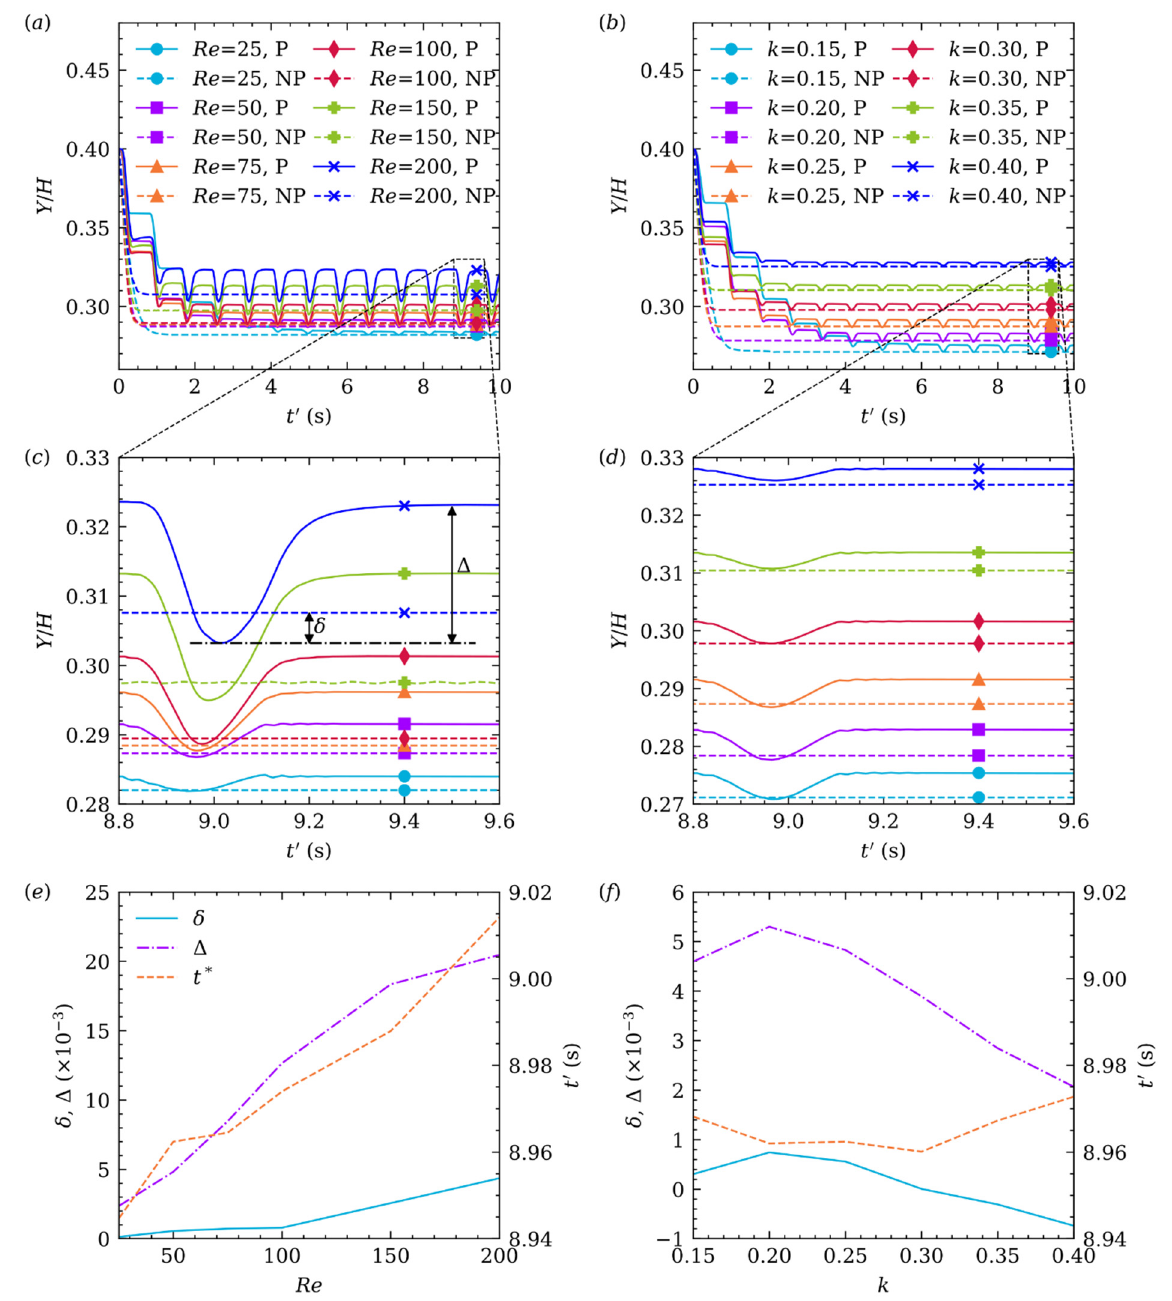
Figure 8. Time history of the particle center trajectory at different Re ( a , c ) at k = 0.25, and different k ( b , d ) at Re = 50. The variation of δ , ∆ , t ∗ with Re ( e ) and k ( f